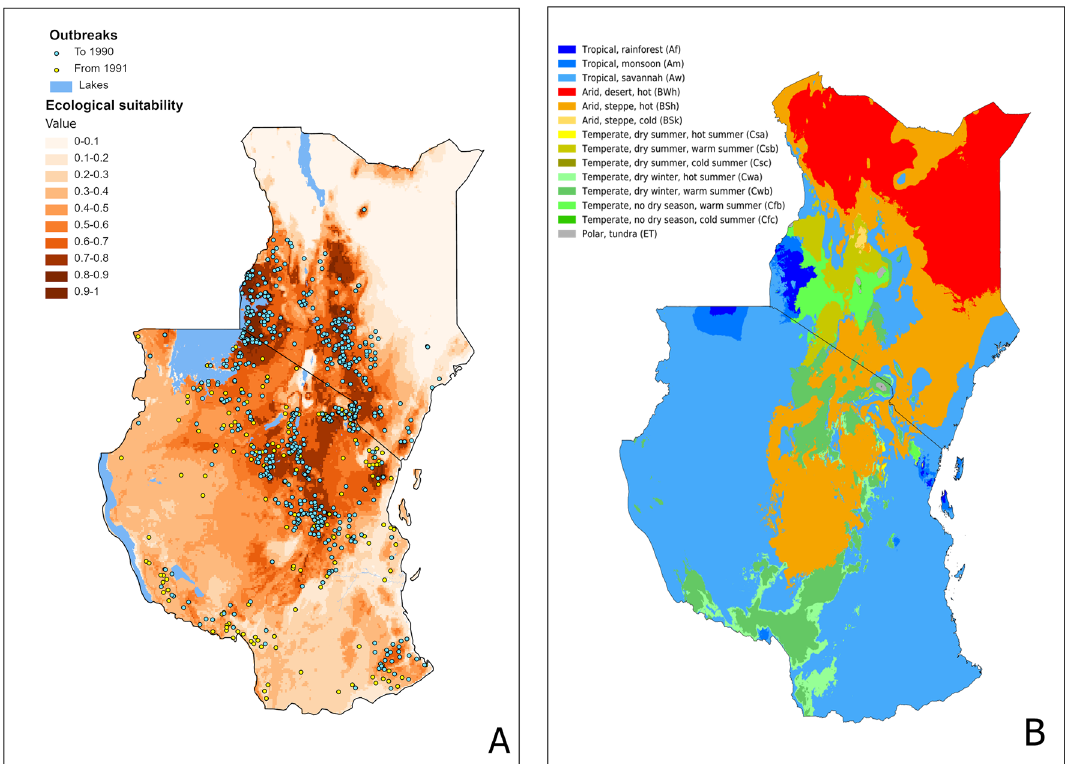
Figure 2. ( A ) S. exempta present-time environmental suitability model for Kenya and Tanzania. Points are the occurrence points from the outbreak data used for the models; ( B ) land cover map for Kenya and Tanzania (after Ref. 44 ). Maps were generated in R v.4.0.2 104 (https:// www.r- proje ct. org/) using RStudio v.1.3.1093 (https:// www. rstud io. com/).